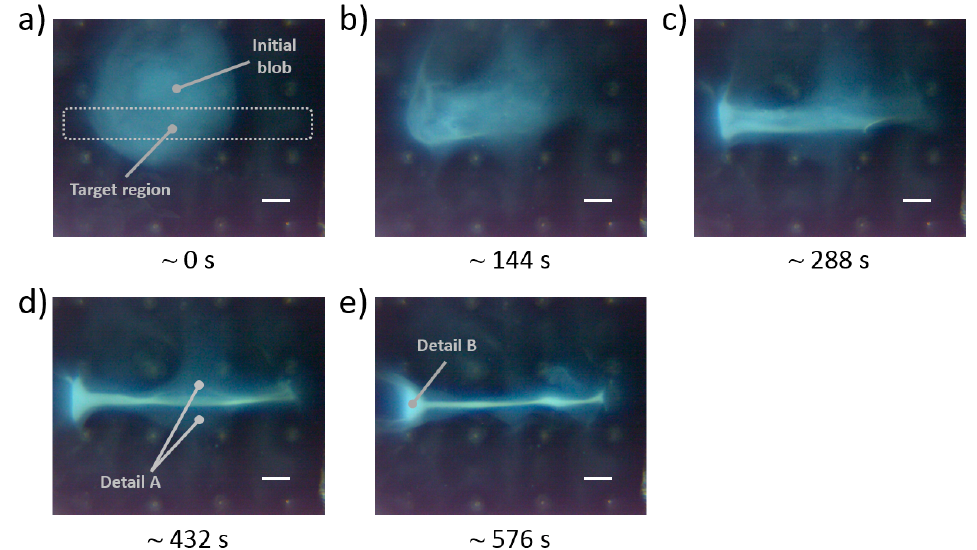
Figure 16. Horizontal midline deposit formation. ( a – e ) Image snapshots during deposit formation with control schemes E and F. The bottom time labels indicate approximate time since the start of the deposition process. The bottom right white line length is 1 mm.